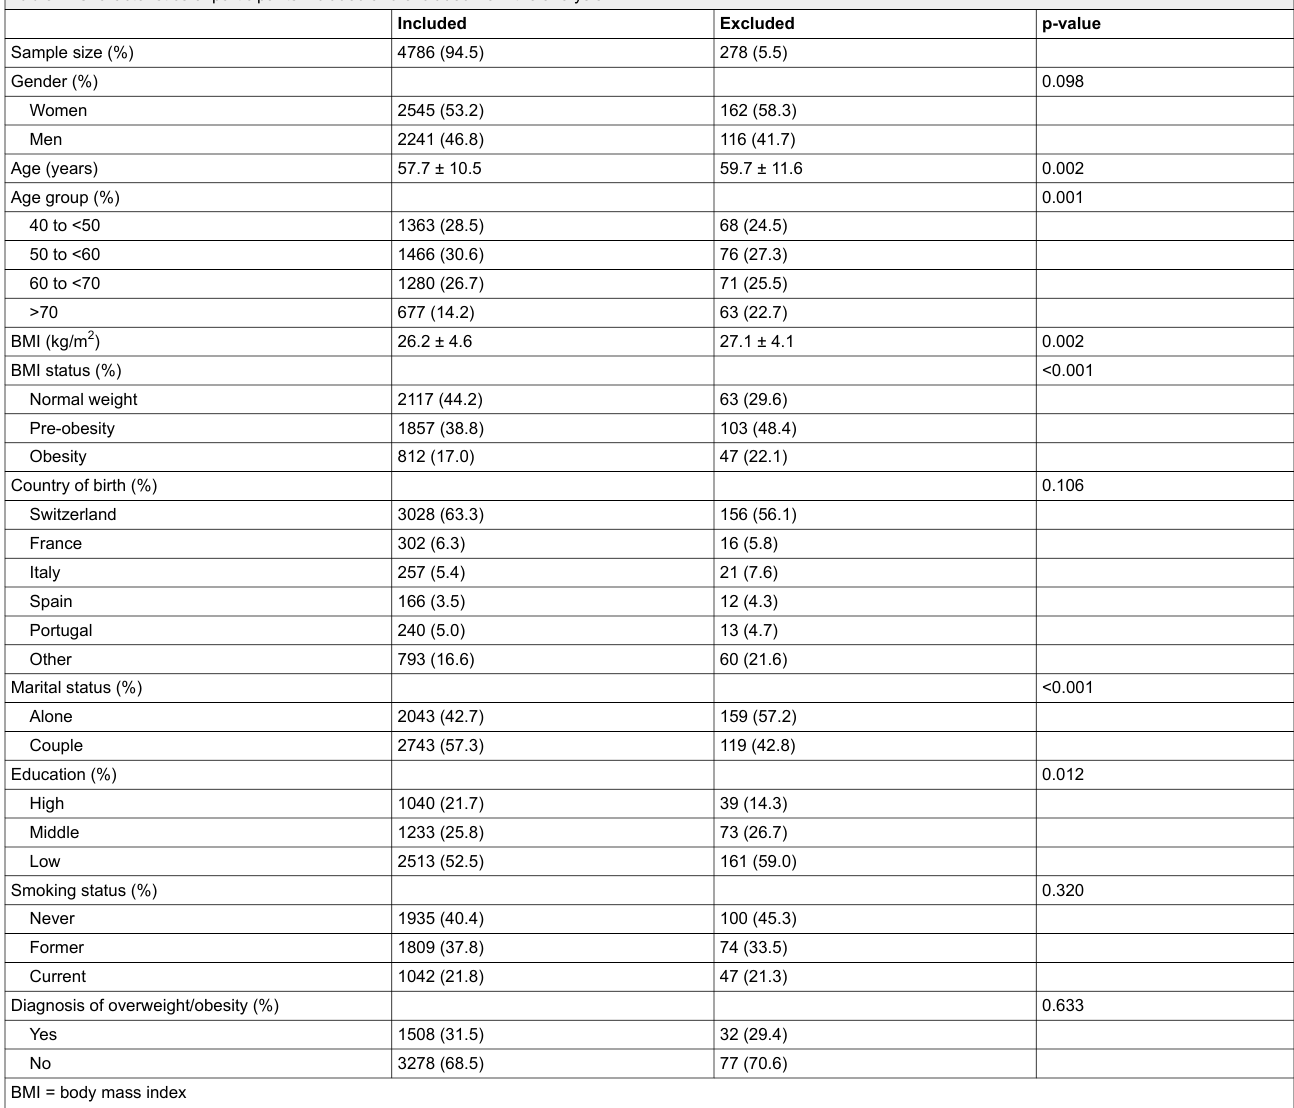
Table 1 : Characteristics of participants included and excluded from the analysis.